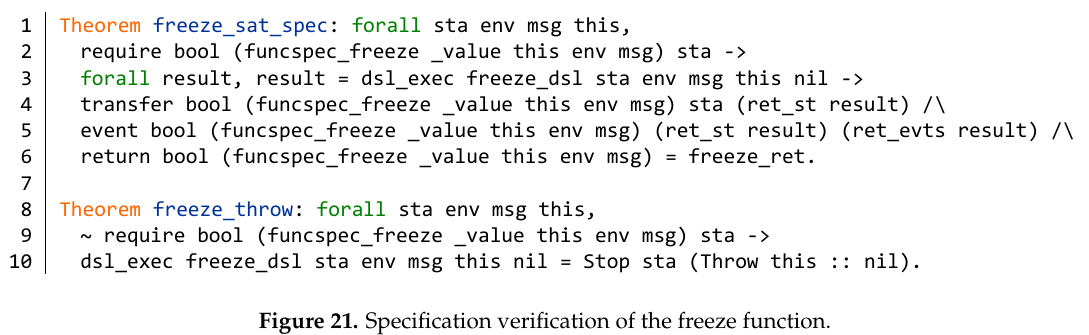
Figure 21. Specification verification of the freeze function.